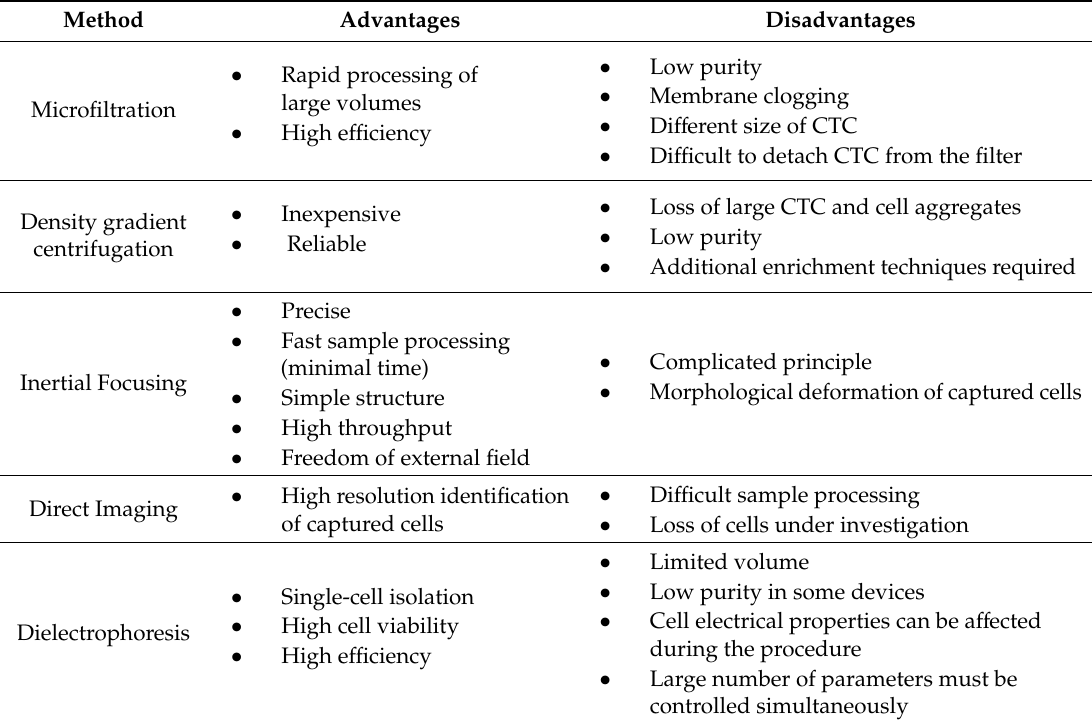
Table 4. Major advantages and disadvantages of CTC label-free detection